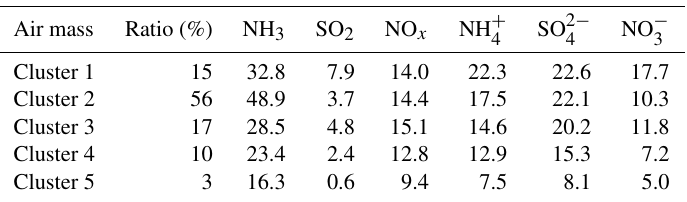
Table 2. Occurrence frequency and mean values of NH 3 , other trace gases (ppb), and ionic species in PM 2 . 5 (µgm − 3 ) for each type of air mass arriving at Gucheng in summer